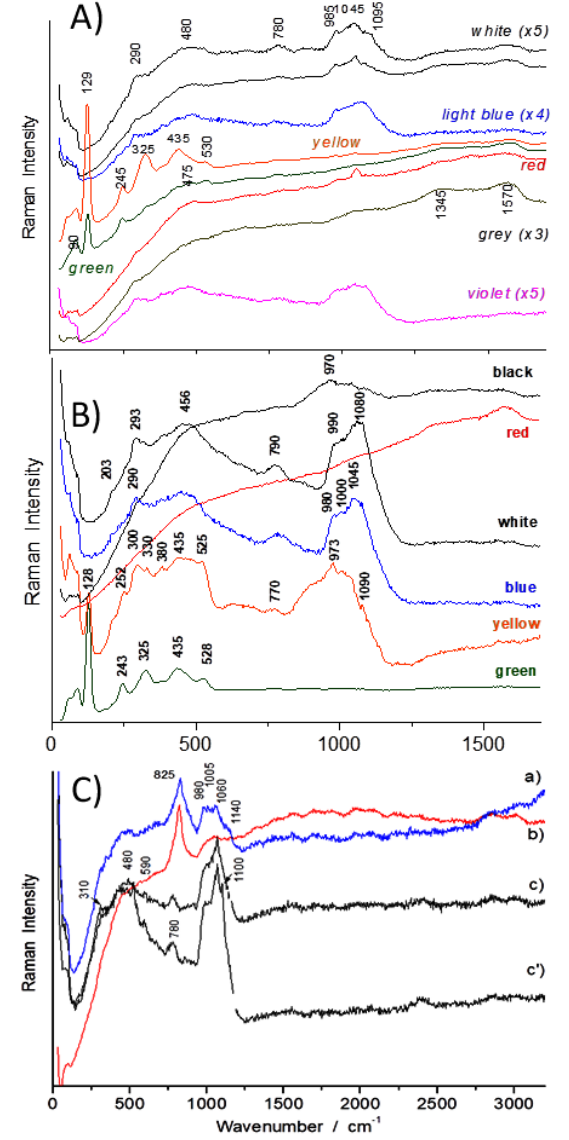
Figure 6. Representative Raman spectra recorded on F1735C ( A , Qianlong period) and F1501 ( B and C , Qianlong period) cloisonn é enamelled wares. For the C Figure; a,b: blue enamelled areas; c,c (cid:48) : white enamelled